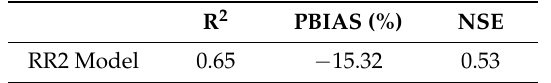
Table 10. RR2’s verification performance (continuous, monthly; n = 38).